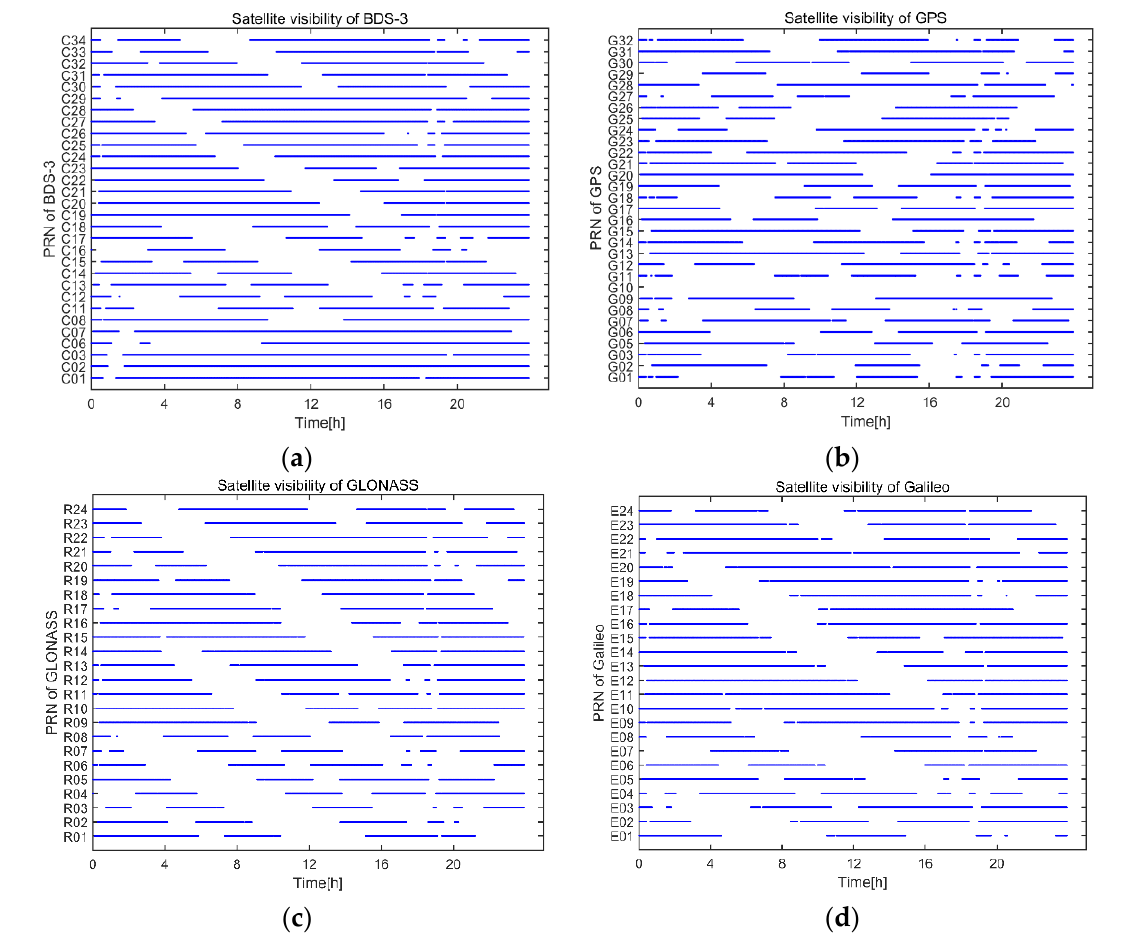
Figure 12. Satellite visibility of HEO. ( a ) Satellite visibility of BDS-3. ( b ) Satellite visibility of GPS. ( c ) Satellite visibility of Galileo. ( d ) Satellite visibility of GLONASS.